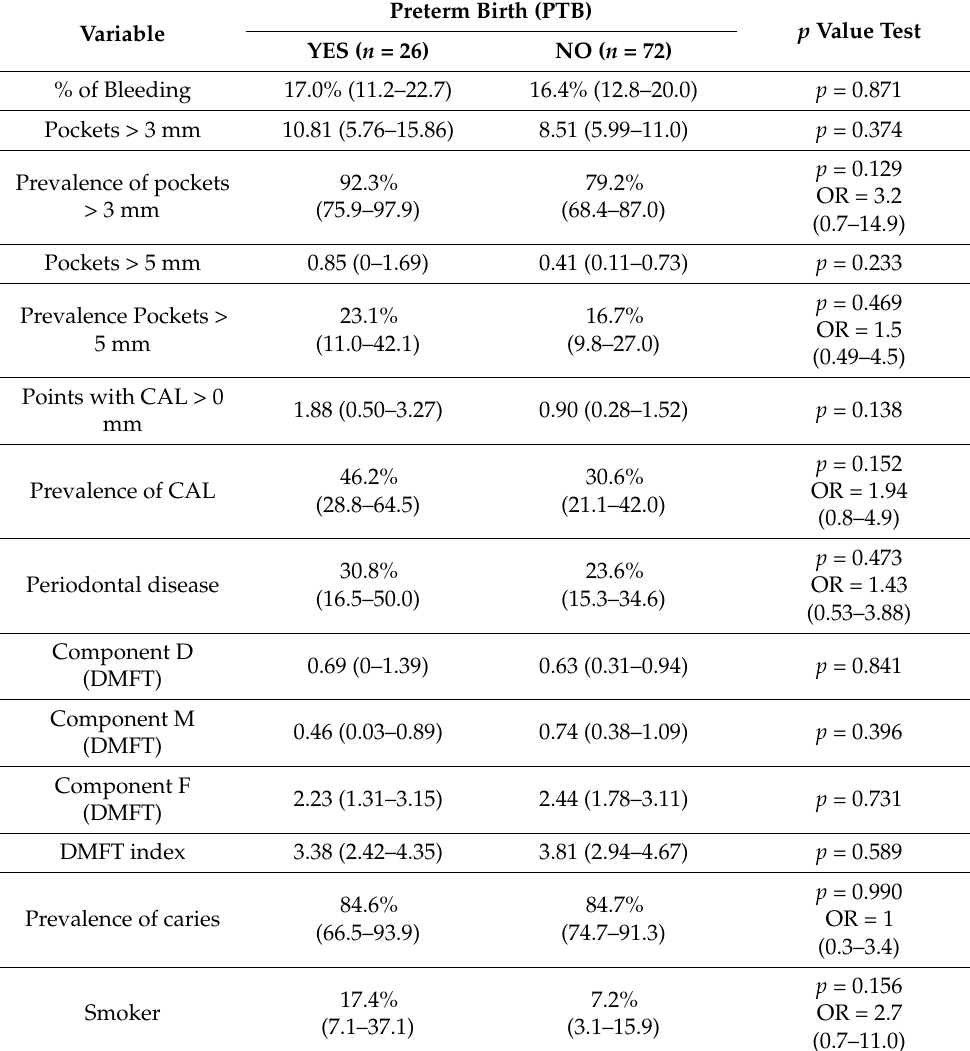
Table 3. Oral health status according to preterm birth